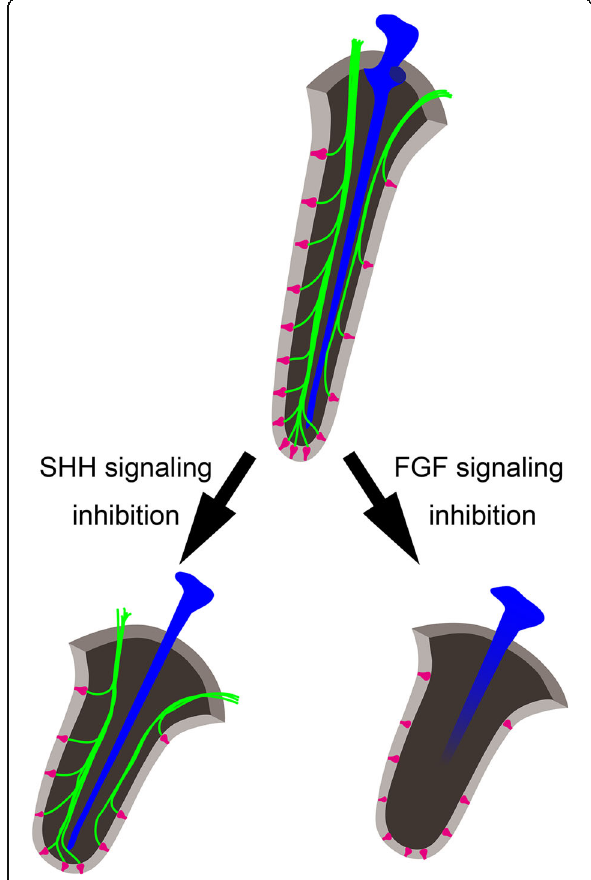
Fig. 10 Summary of effects of SHH and FGF signal inhibitors on barbel